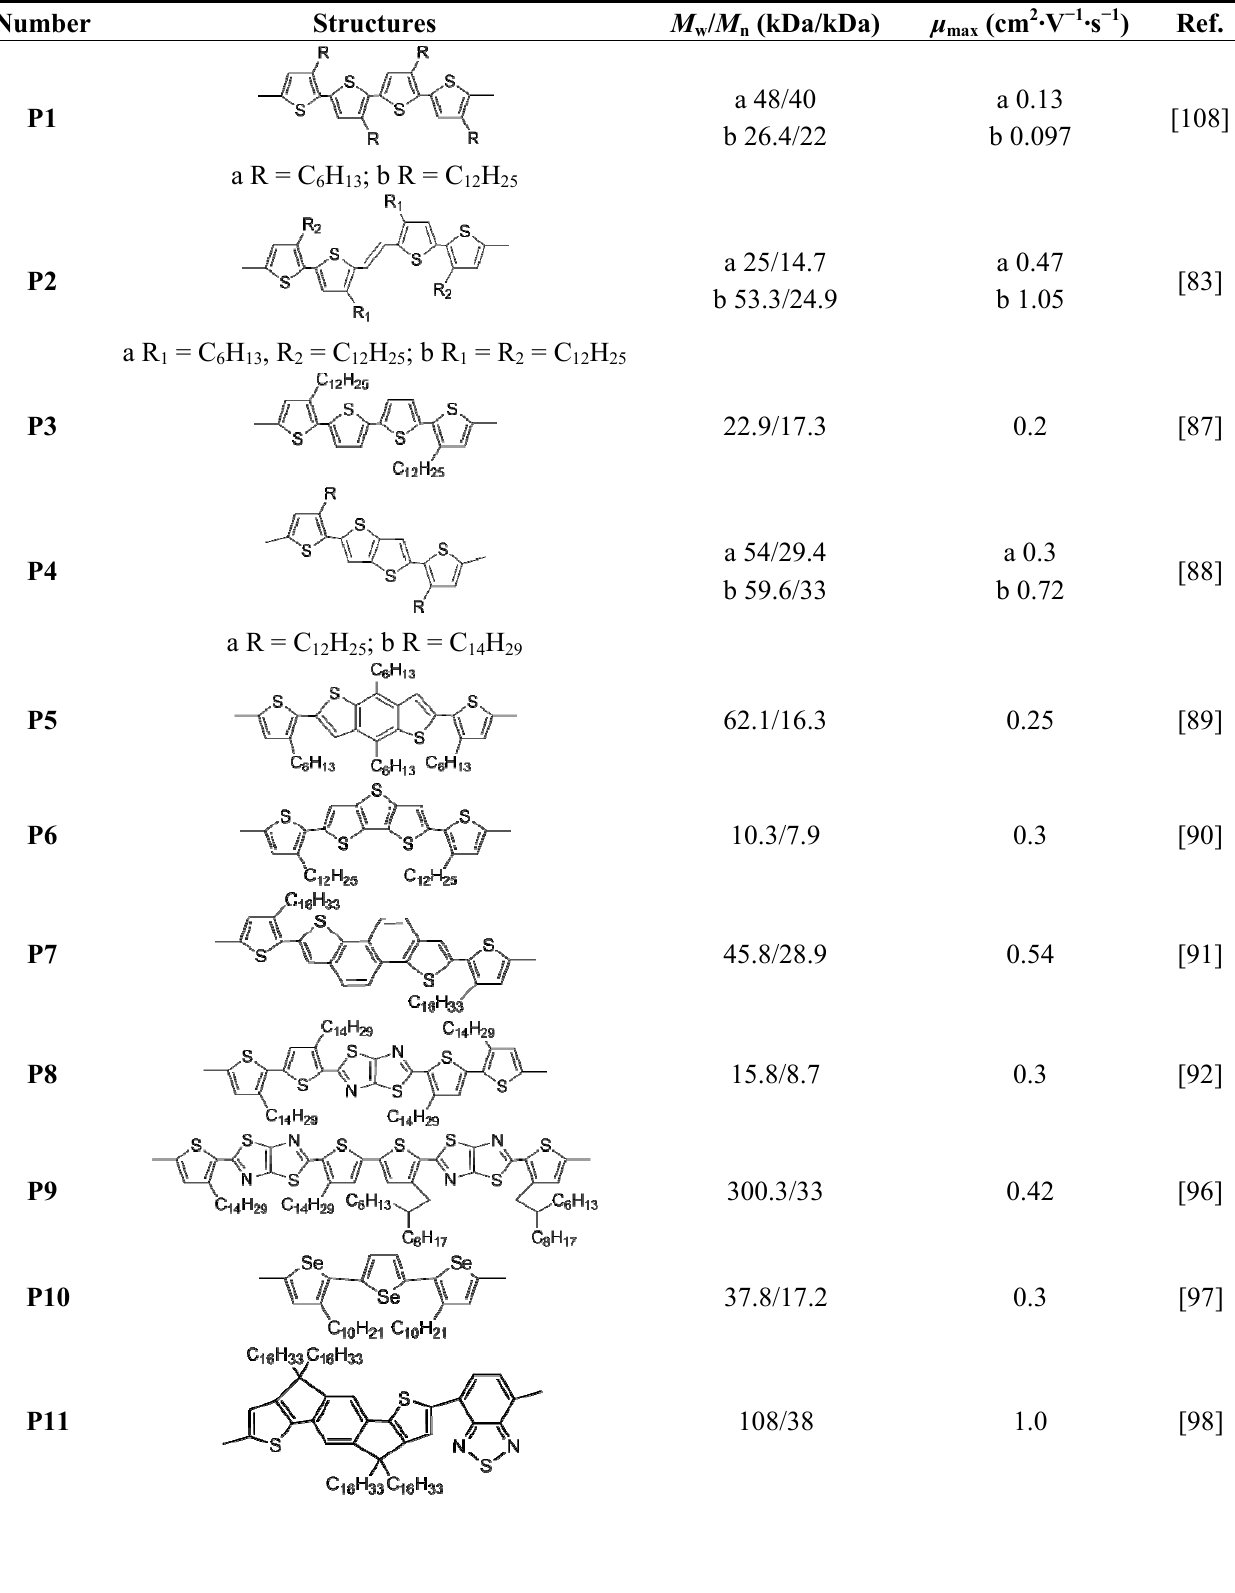
Table 1. Summary of conjugated polymers indicating the effect of structures on the carrier mobility in TFT devices (the mobility is that of holes except P14 and P17